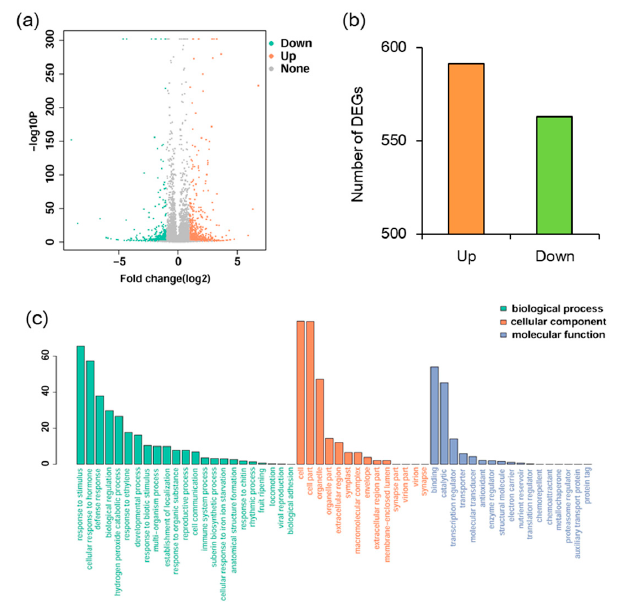
Figure 4. Analyses of differentially expressed genes (DEGs) between the wild-type (WT) and MYB102-OX3 lines. ( a ) Volcano plot showing up- and down-regulated DEGs. The x -axis indicated the value of log2 (OX3/WT), and the y -axis indicated the value of − log10 (1-probability). ( b ) Statistics of up- and down-regulated DEGs. The x -axis indicated downregulated and upregulated genes, and the y -axis indicated the number of DEGs. ( c ) Most enriched Gene Ontology (GO) terms of DEGs were categorized into biological process, cellular component, and molecular function. The x -axis indicates GO terms and the y -axis indicates the percent of genes in all the DEGs.